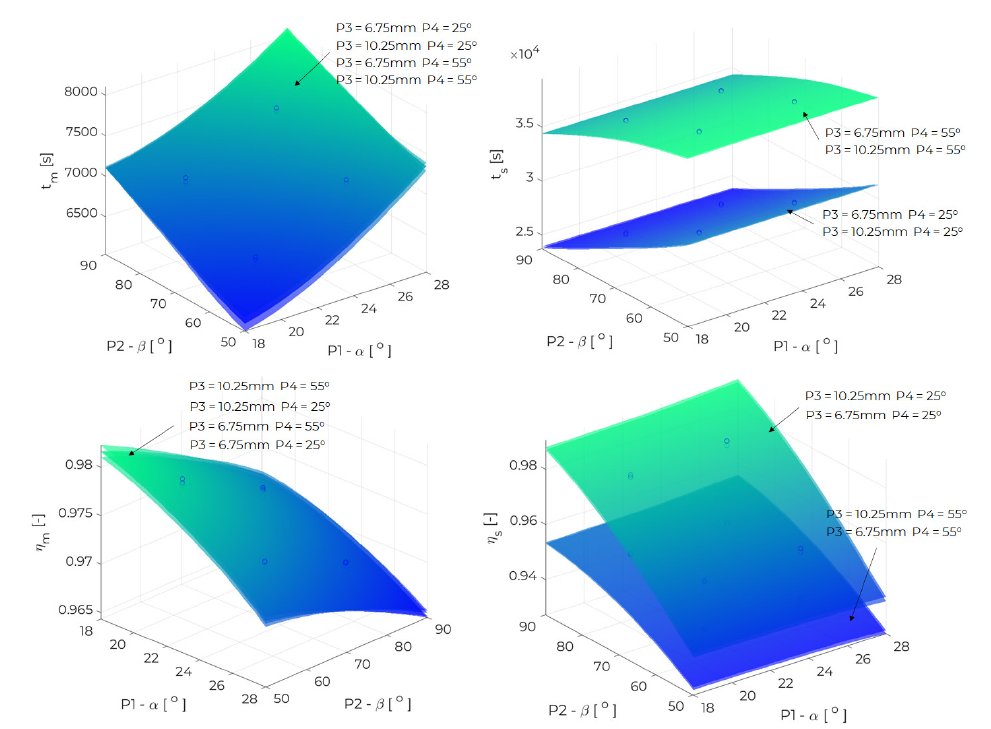
Figure 13. The response surface for inputs P1, P2, outputs t m , t s , η m , η s and (P3, P4) = [(6.75 mm, 25 ◦ ),